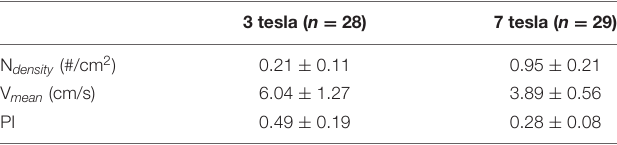
TABLE 2 | Perforating artery flow at 3 and 7 tesla MRI using all detected perforating